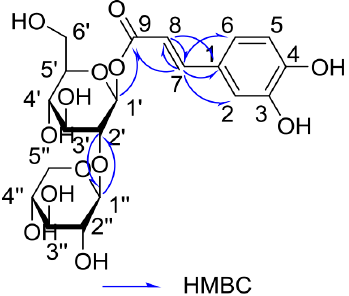
Figure 3. Heteronuclear Multiple Bond Correlation (HMBC) correlations of 1 .